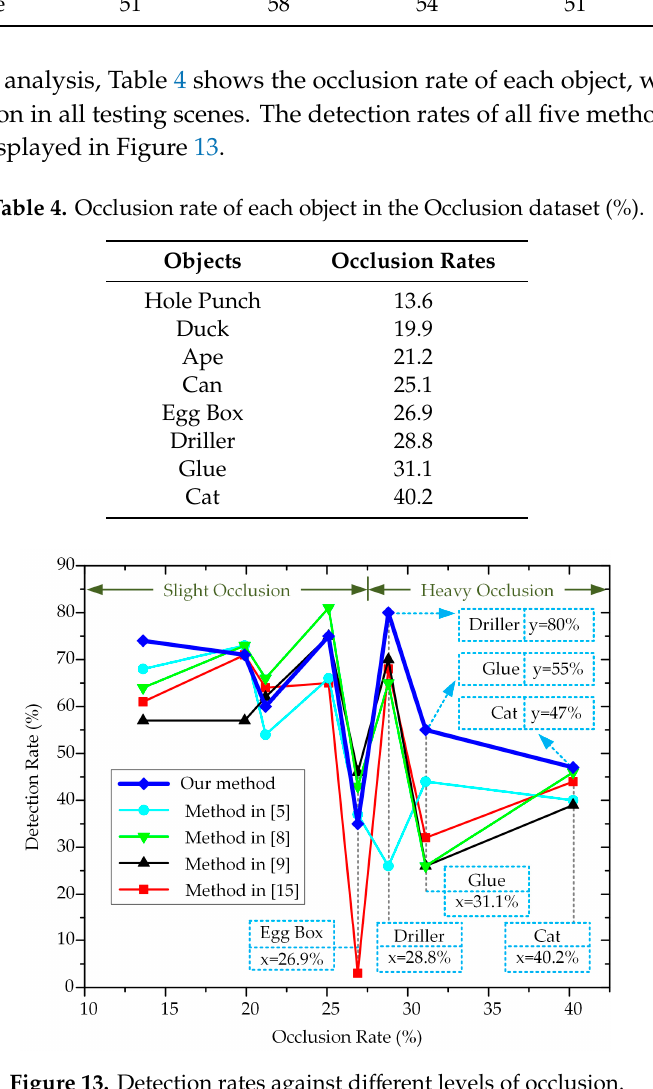
Figure 13. Detection rates against different levels of occlusion.